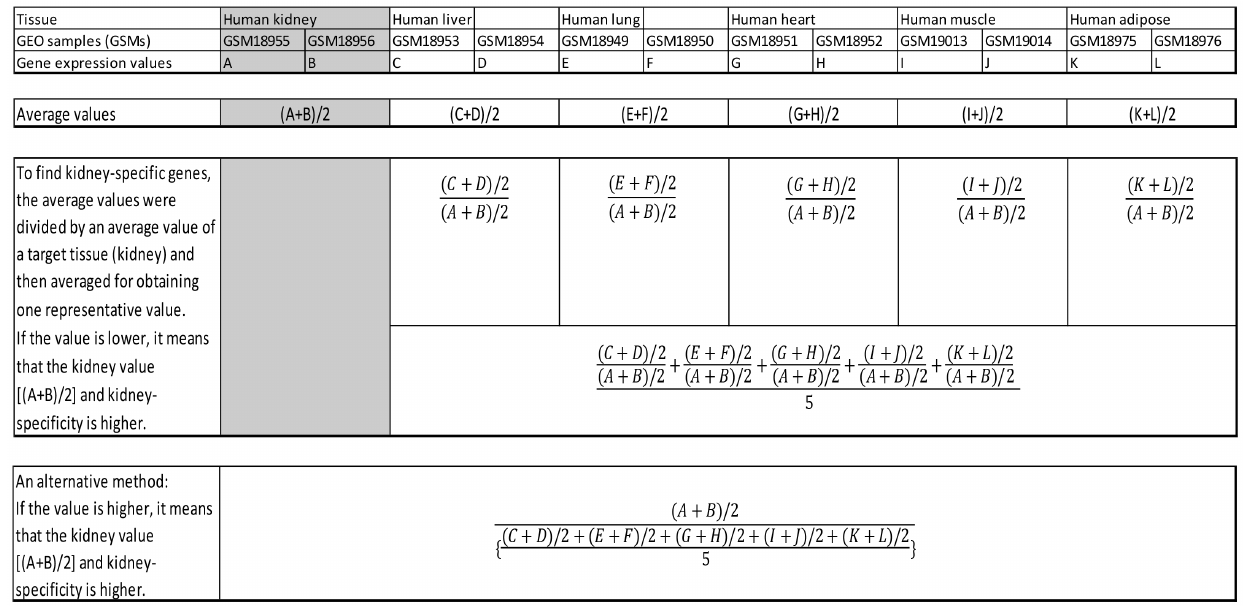
Figure 1. Steps for selecting kidney-specific genes. Tissue-specific genes were determined as follows: i) Gene expression values for each tissue were averaged; ii) The averaged values were divided by an averaged value for kidney; iii) The results were averaged and sorted in ascending order with a lower value representing higher tissue-specific expression. Highly ranked genes with lower values are candidates for kidney-specific genes; iv) An alternative method for finding tissue-specificity is to divide an average gene expression value for kidney by an average of averages of gene expression values in other tissues.